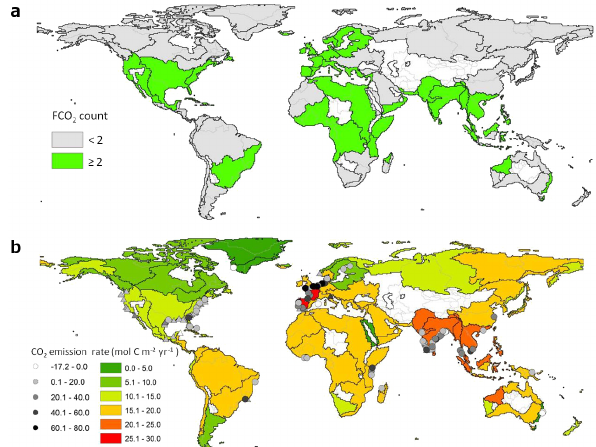
Fig. 7. (a) Number of local air–water CO 2 flux estimates available per MARCATS (black lines), COSCAT limits are indicated by grey lines. (b) Air–water CO 2 emission rates for estuaries from direct estimates (dots) and derived from net ecosystem metabolism (tri- angles). Mean rates per MARCATS are represented by the colour